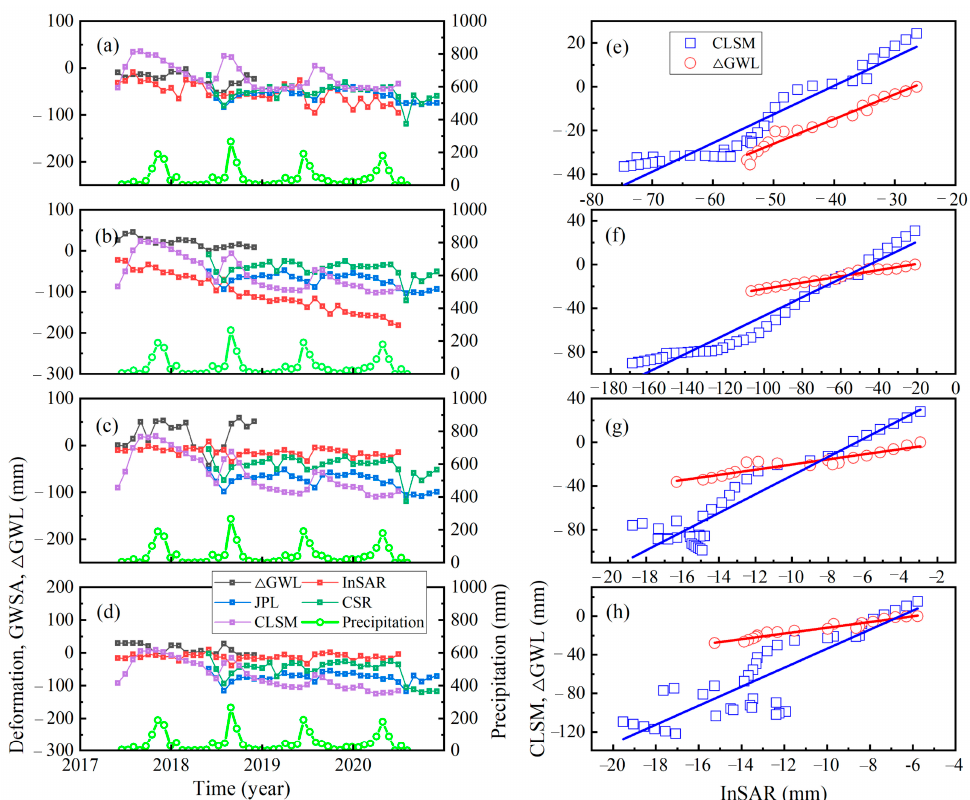
Figure 8. Sedimentation grids extracted from InSAR deformation.